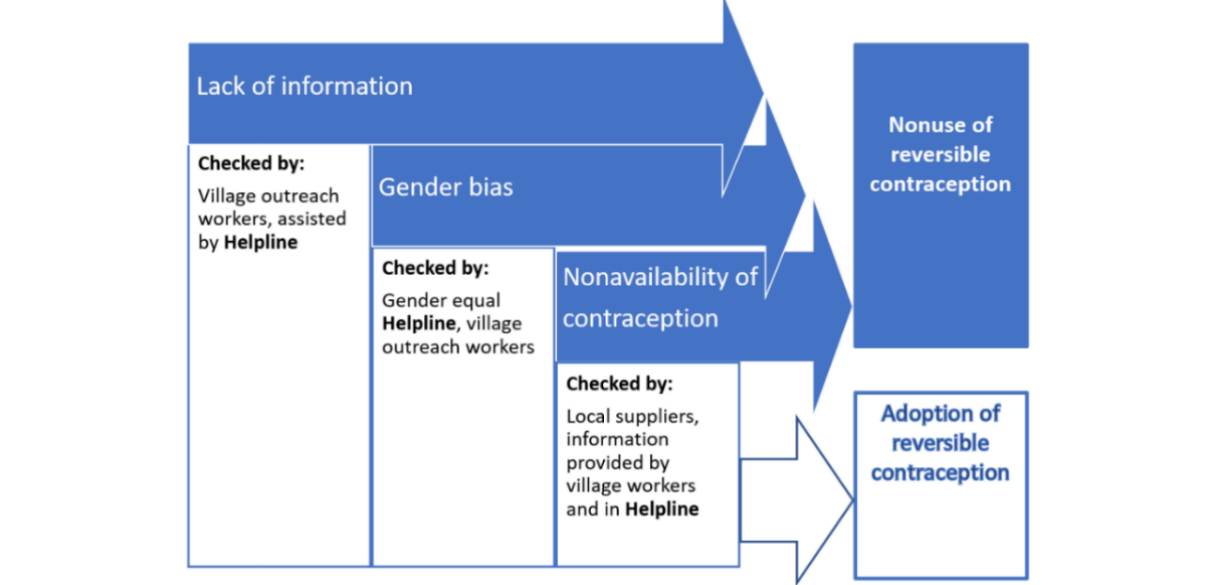
Figure 1. The role of the helpline in the intervention’s theory of change (hindrances in dark arrows and intervention activities in white boxes).